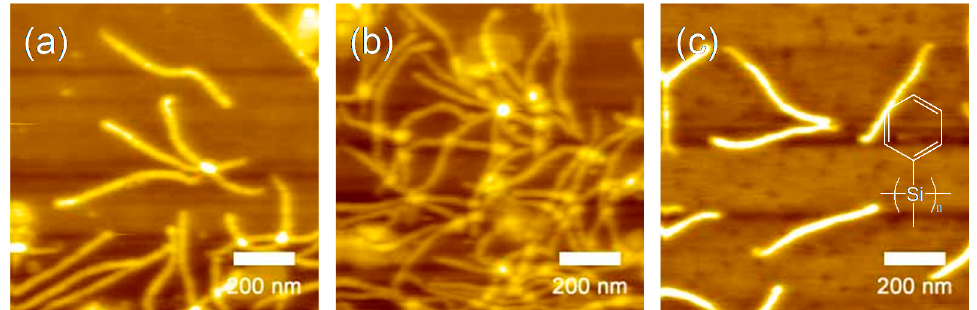
Figure 1. AFM micrographs of polysilane based nanowires. The nanowires were formed by 500 MeV 197 Au particle irradiation to ( a , b ) polysilane ( M n = 1.2–1.5 × 10 4 kg mol − 1 ) and ( c ) polysilane ( M n = 3.3–6.8 × 10 5 kg mol − 1 ) thin films at ( a ) 3.0 × 10 9 , ( b ) 5.0 × 10 9 , and ( c ) 1.0 × 10 9 particles cm − 2 , respectively. The thickness of the target films were ( a , b ) 350 nm and ( c ) 250 nm. Reprinted with permission from